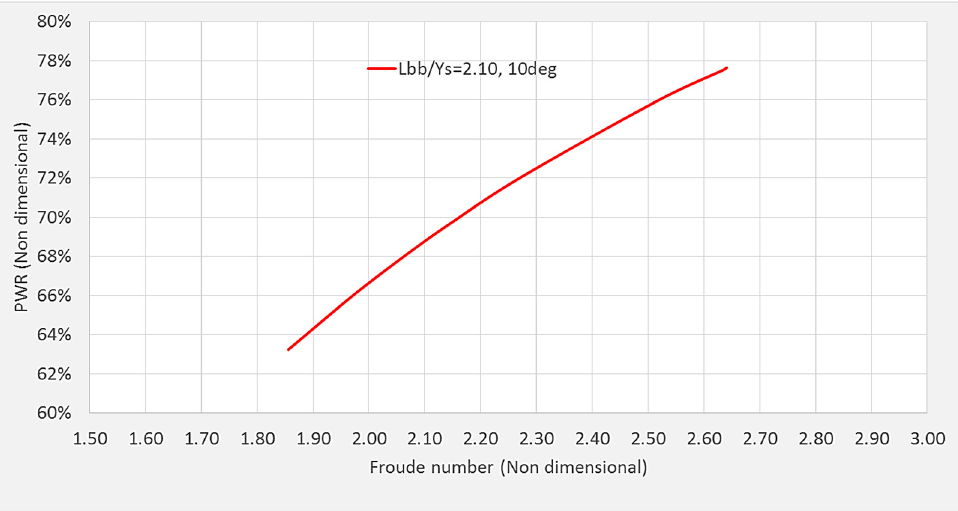
Figure 29. Proposed PWR approximation using normalized bulb length, and 5 ˚ pitch angle. Figure 28. Proposed PWR approximation using normalized bulb length, and 5